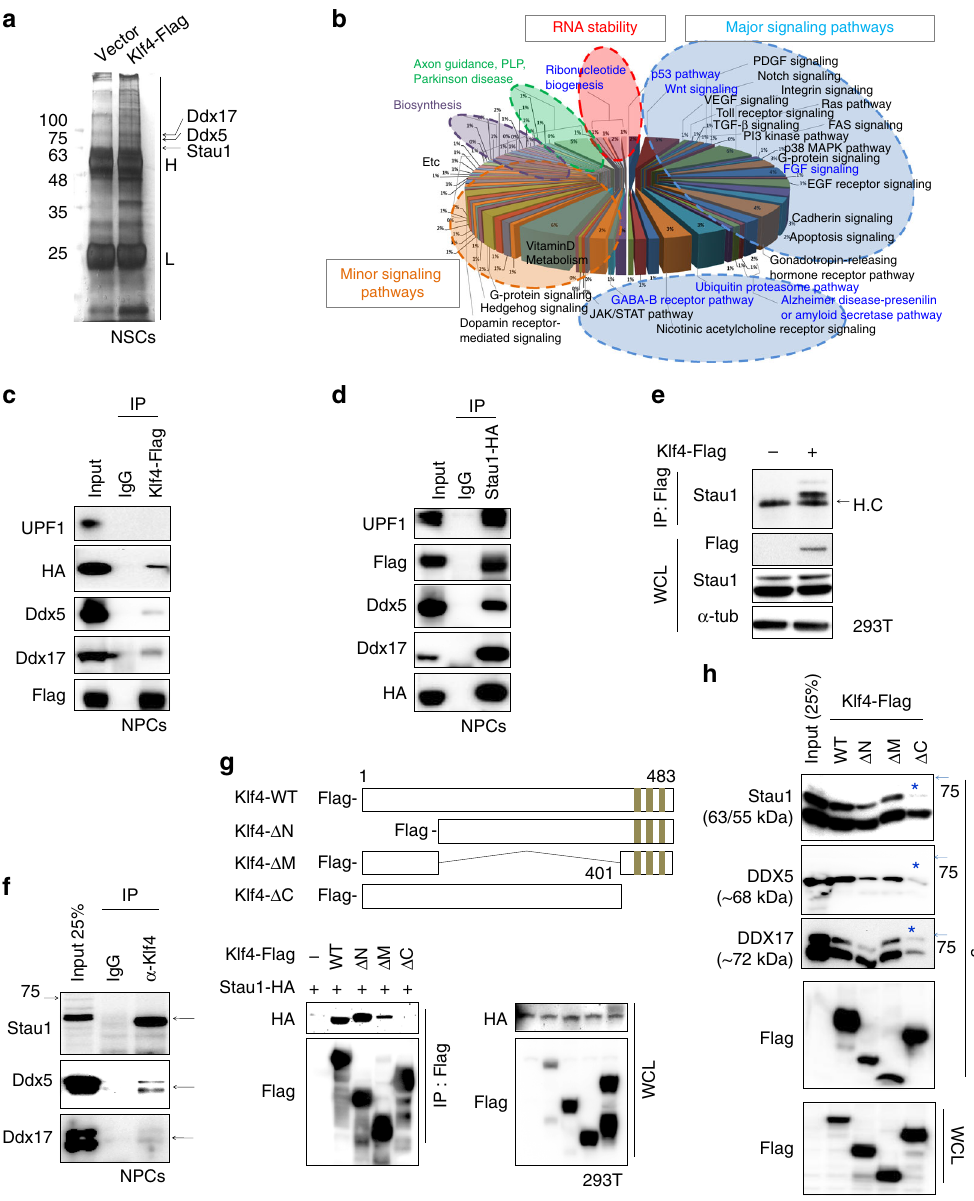
Fig. 3 Stau1 interacts with Klf4 in NPCs. a Anti- fl ag immunoprecipitates from Flag-Klf4-NPCs were separated by SDS-PAGE and visualized by silver staining. Speci fi c bands were cut and analyzed by mass spectrometry. b GO analysis of the Klf4 interactome in NPCs. Several enriched Klf4 interaction partners are associated with post-transcriptional RNA regulation, among them are the RNA-binding protein Stau1 and RNA helicases of the DDXs protein family. c Co-immunoprecipiation of HA-Stau1 or endogenous UPF1, Ddx5, and Ddx17 in NPCs infected with Flag-Klf4 and HA-Stau1 lentivirus using anti-IgG (negative control), or anti-Flag antibodies ( n = 2). d Co-IP of Flag-Klf4 or endogenous UPF1, Ddx5, and Ddx17 in NPCs infected with Flag-Klf4 and HA-Stau1 lentivirus using anti-IgG (negative control), or anti-HA antibodies ( n = 2). e Co-IP of endogenous Stau1 in HEK293T cells transfected with Flag-tagged Klf4. f Co-IP of endogenous Stau1 and Klf4 in undifferentiated NPCs using anti-IgG (negative control) and anti-Klf4. g Domain mapping of Klf4 interaction with Stau1. (Upper) Schematic showing domains deleted from wild-type Klf4 protein. (Lower) Co-IP of Klf4 mutants with HA-tagged Stau1 in cells expressing full-length HA-tagged Stau1 and Flag-tagged Klf4 mutants. IP was performed using anti-Flag antibody-conjugated agarose beads and immunoblotting with anti-HA and anti-Flag antibodies. h Co-IP of endogenous Stau1, Ddx5, and Ddx17 in NPCs transfected with Klf4 mutants and/or Stau1. Blue asterisks indicate position of each protein. See also Supplementary Fig. 7e – h and 16 – 18. H IgG heavy chain, L IgG light chain, WCL whole cell